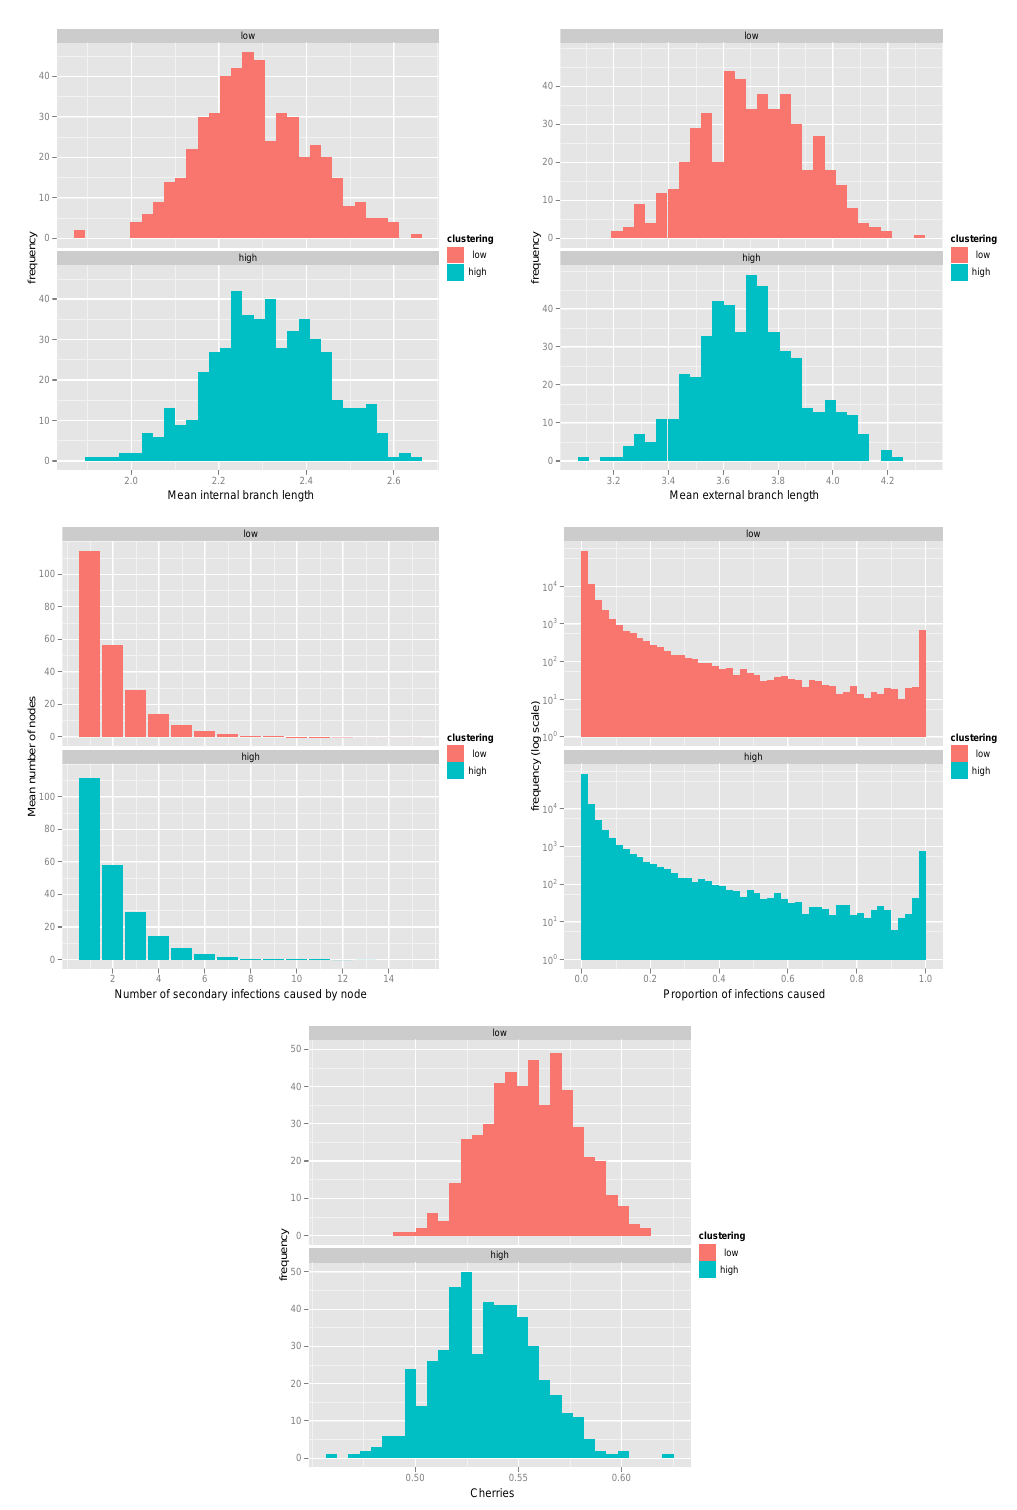
Figure 5. Empirical distributions of summary statistics of transmission trees from epidemics on Bernoulli networks. (top left) Mean internal branch length; (top right) Mean external branch length; (middle left) Number of secondary infections by node; (middle right) Number of total infections by node, vertical axis on log-scale; and, (bottom) Number of cherries in tree as a proportion of possible